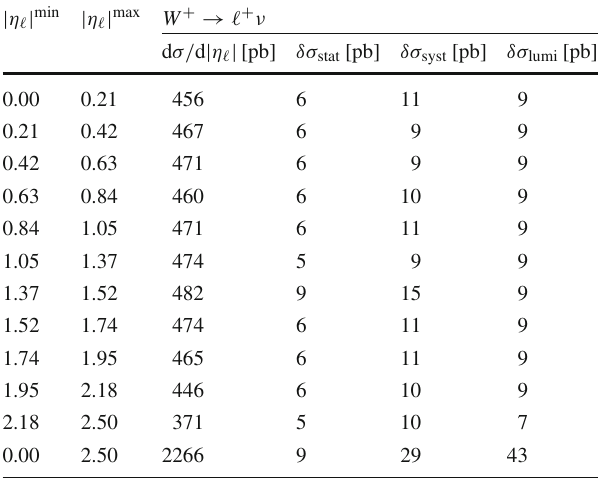
Fig. 9 Differential Z boson production cross section as a function of absolute lepton-pair rapidity, for the electron, muon and combined results. Statistical and systematic errors are shown as corresponding bars and shaded bands. The luminosity uncertainty is not included. The lower panel shows the ratio of channels to the combined differen- tial cross section in each bin. In the lower panel, error bars represent statistical uncertainties in the ratio, while the shaded band represents systematic uncertainties in the combined differential cross sections Table 6 Combined fiducial W + → (cid:5) + ν differential and integrated cross sections